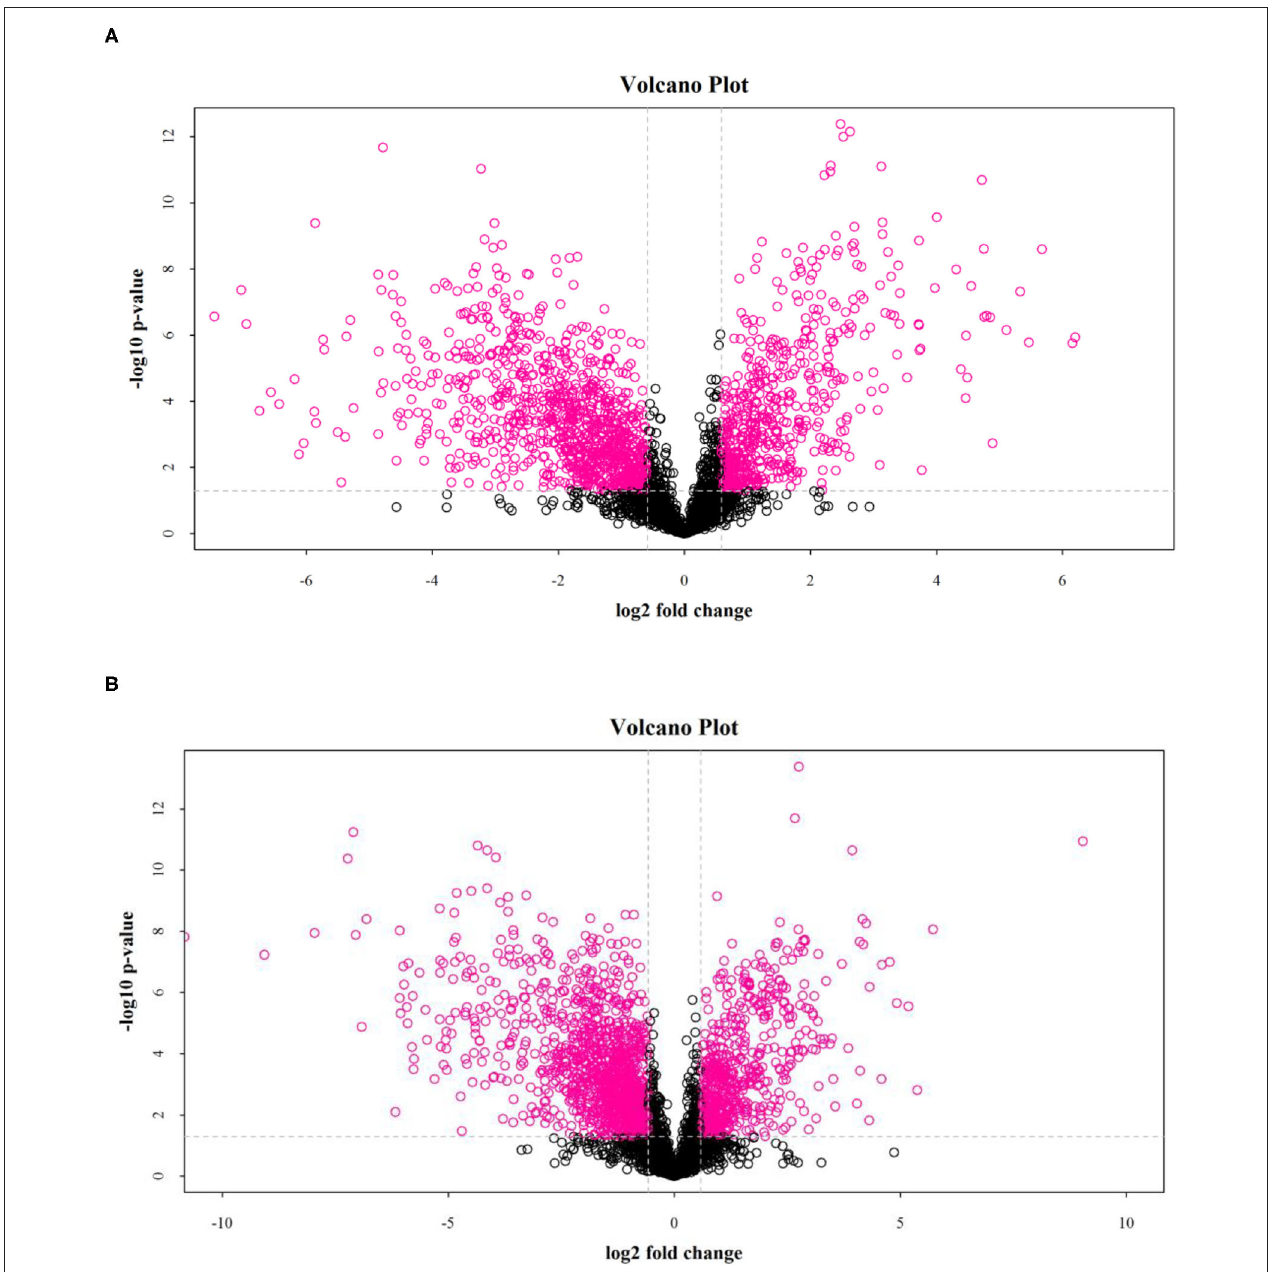
FIGURE 3 | Volcanic diagrams of a positive ion model (A) and a negative ion model (B) between DN and DS. Each point in the picture represents a metabolite. DN is DXWR without salt treatment and DS is DXWR under